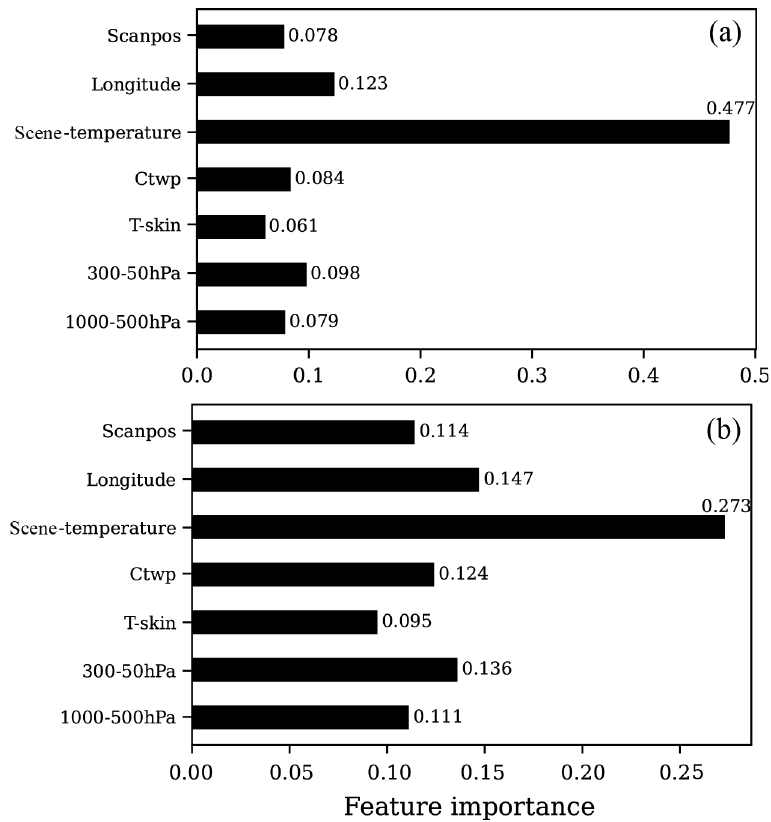
Figure 3. Feature Importance of the applied predictors in the RF model for AGRI ( a ) channel 9 and ( b ) channel 10. The sum of all importance scores is 1.